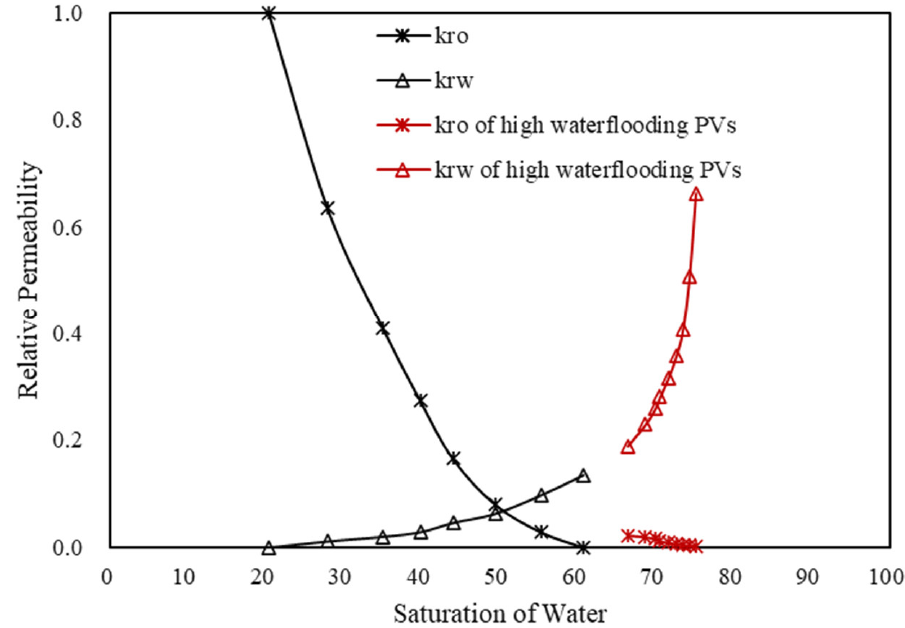
Figure 3. Relative permeability curve of #4 (K = 1793.1 mD).